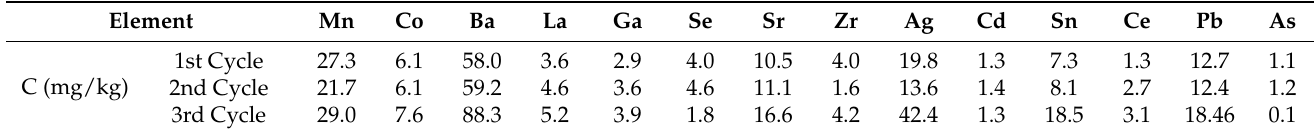
Table 3. Concentrations of major elements present in the waste after treatment obtained by ICP.